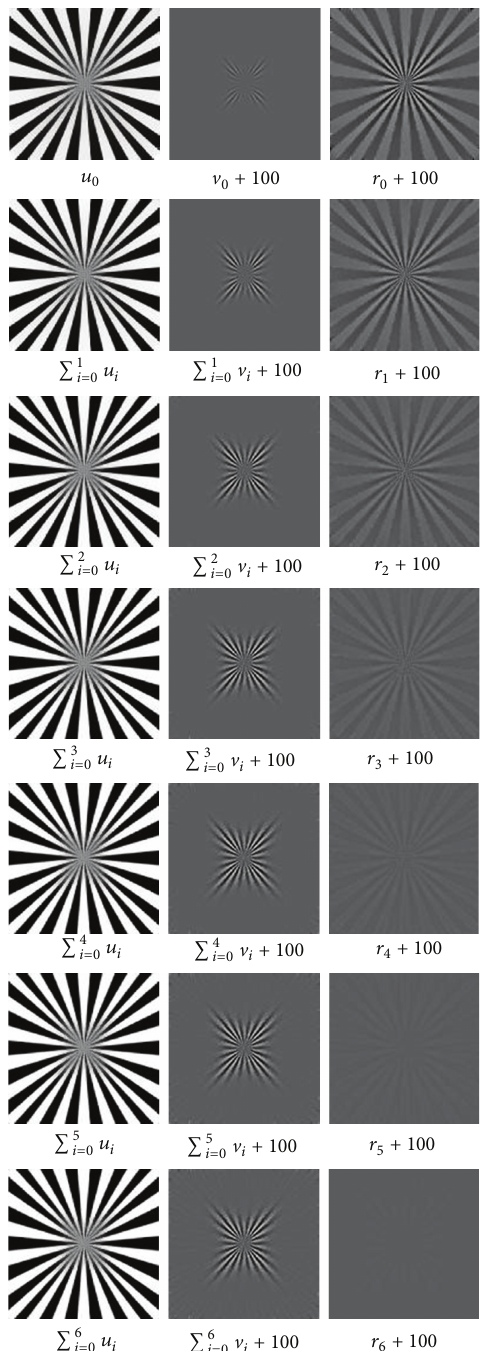
Figure 2: Hierarchical decomposition of a synthetic image for 7